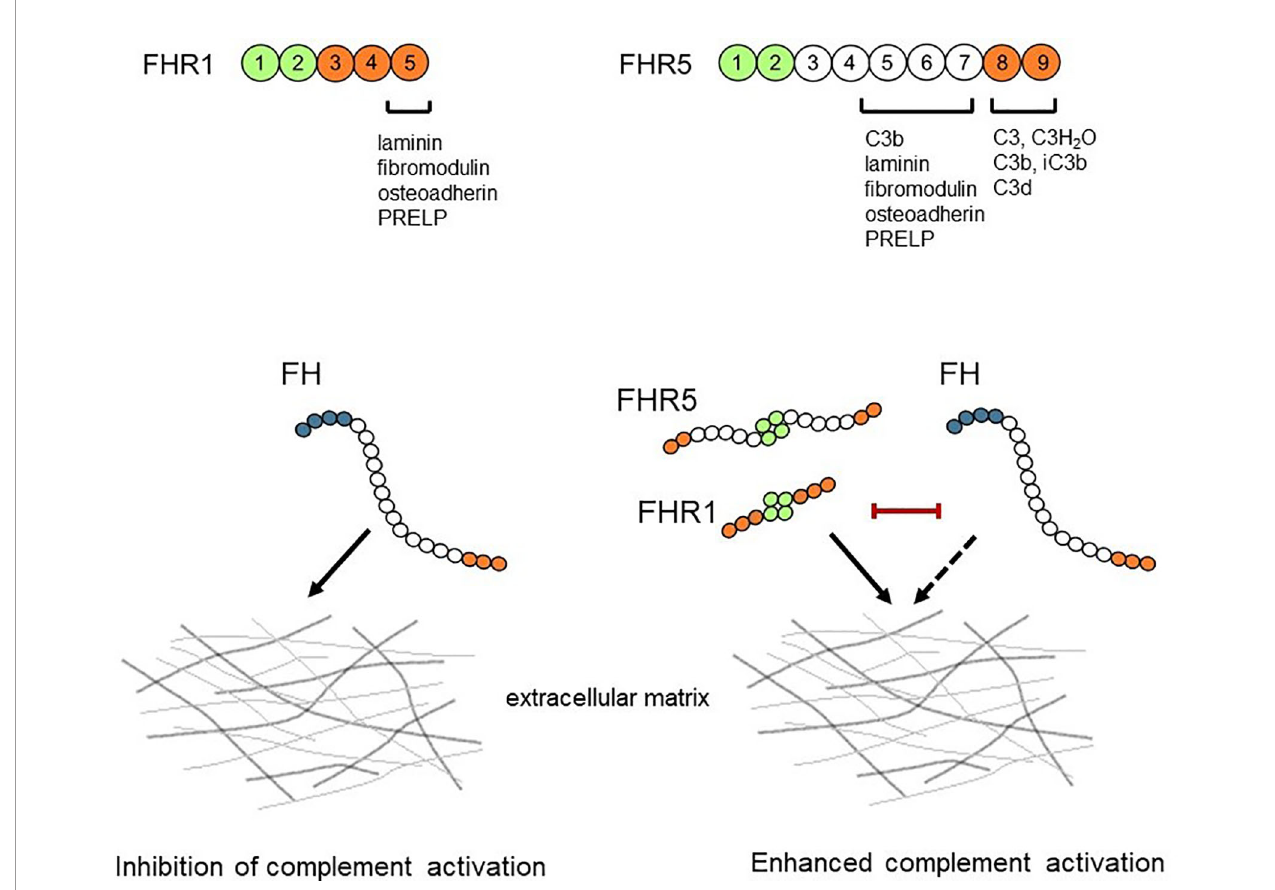
FIGURE 10 | Schematic overview of the interaction between FH/FHRs and the ECM. FHR1 and FHR5 can bind to ECM components and competitively inhibit the binding of FH, thus reducing the complement regulatory activity of FH. The ECM-bound FHR1 and FHR5 may also directly enhance alternative pathway activation by binding C3(H 2 O) and C3b and allowing formation of C3